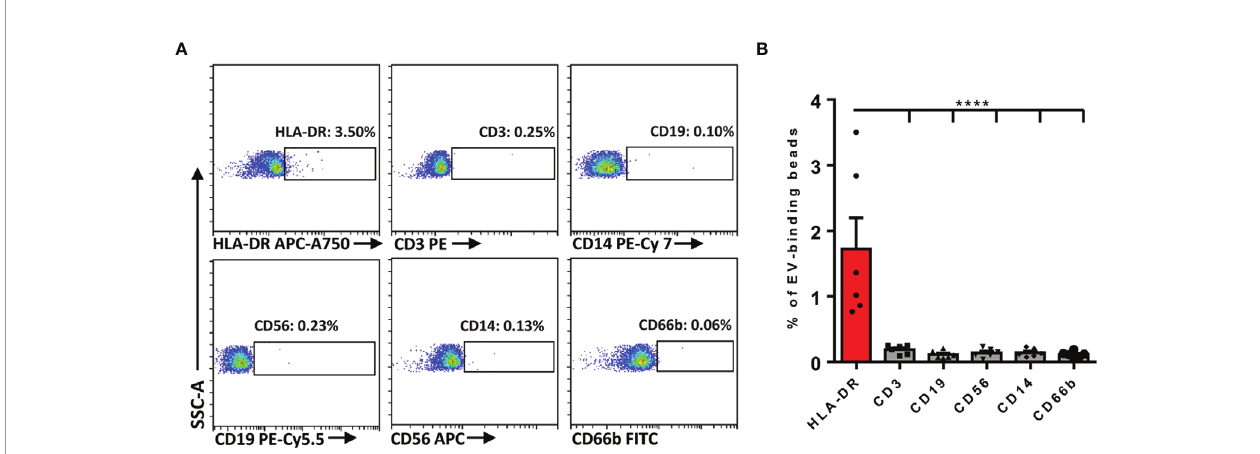
FIGURE 2 | Determination of the immunocyte-associated markers on plasma EVs of AR patients. (A) Representative dot plots for fl ow cytometry analysis of immunocyte-related markers on plasma EVs. (B) Flow cytometry analysis of the expression of immunocyte-related markers on plasma EVs. Data are shown as mean ± SEM. **** p < 0.0001 by one-way ANOVA multiple